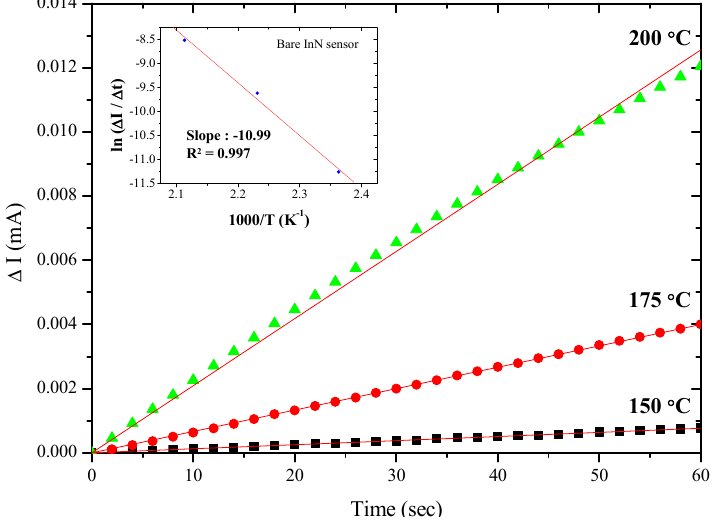
), and response/recovery times 0